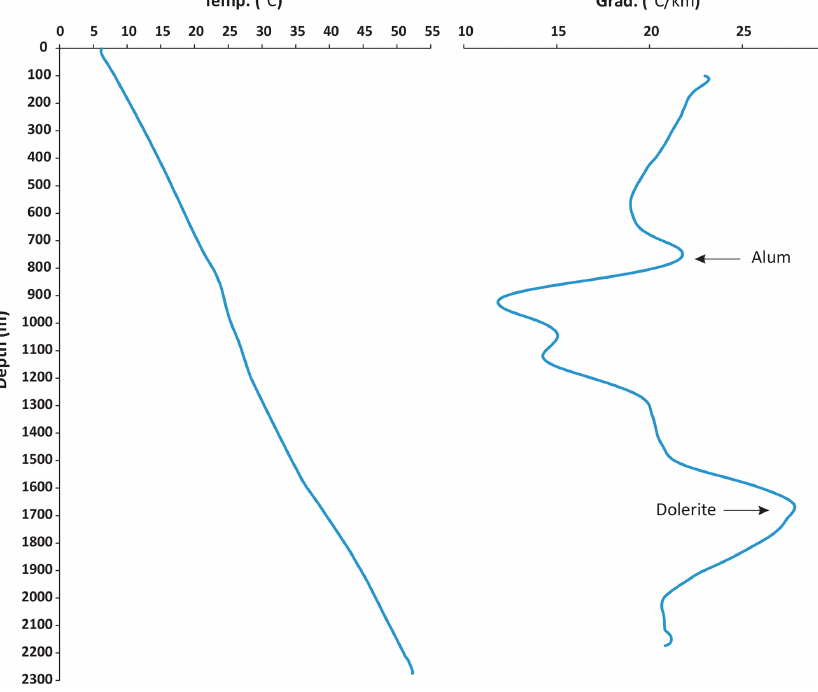
Figure 8. Temperature profile and thermal gradient for the COSC-2 drill hole. The thermal gradient was computed using a moving window of